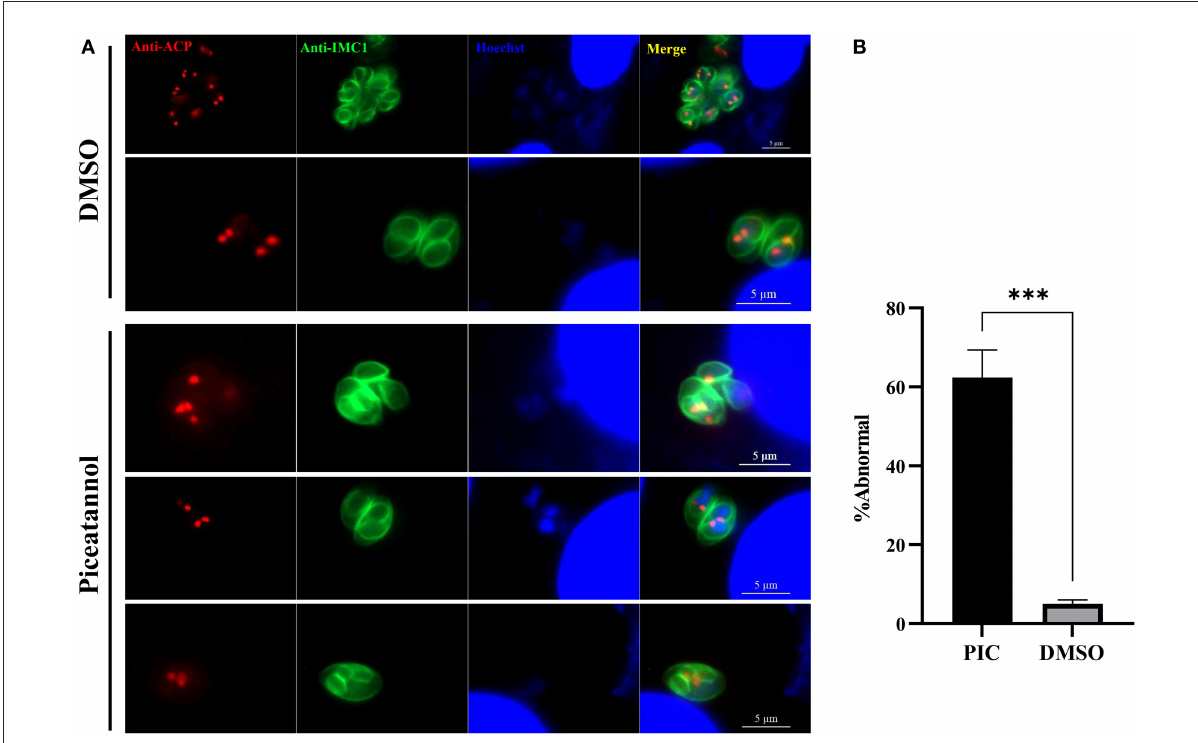
FIGURE4 Piceatannol exposure resulting in abnormal development of T. gondii . Indirect immunofluorescent assay was performed after 100 µ M piceatannol treatment to observe the dividing of the parasite. Organelles including IMC, apicoplast and nuclei were stained by using rabbit anti-IMC1 antibody, mouse anti-ACP antibody and Hoechst dye, respectively. (A) Abnormal division of T. gondii after piceatannol or DMSO treatment. (B) The proportion of abnormal divided parasites after piceatannol or DMSO treatment. The proportion of vacuoles containing abnormally splitting tachyzoites was calculated under fluorescence microscopy and the average value was taken three times. Statistical analysis of the plaque area was performed by Graph Pad Prism using Student’s t test. *** , p < 0.001.